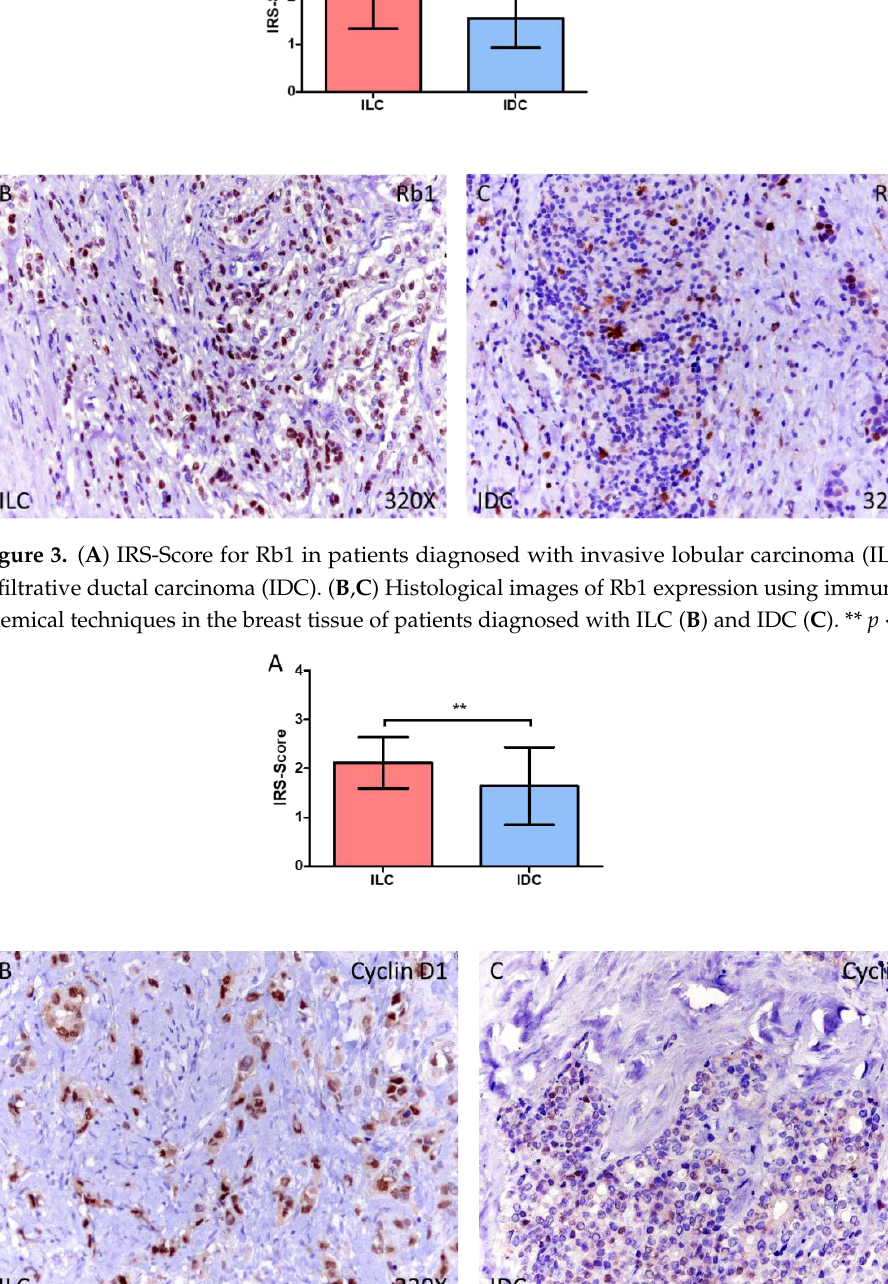
Figure 4. ( A ). IRS-Score for Cyclin D1 in patients diagnosed with invasive lobular carcinoma (ILC) and infiltrative ductal carcinoma (IDC). ( B , C ). Histological images of Cyclin D1 expression using immuno- histochemical techniques in the breast tissue of patients diagnosed with ILC ( B ) and IDC ( C ). ** p < 0.005.